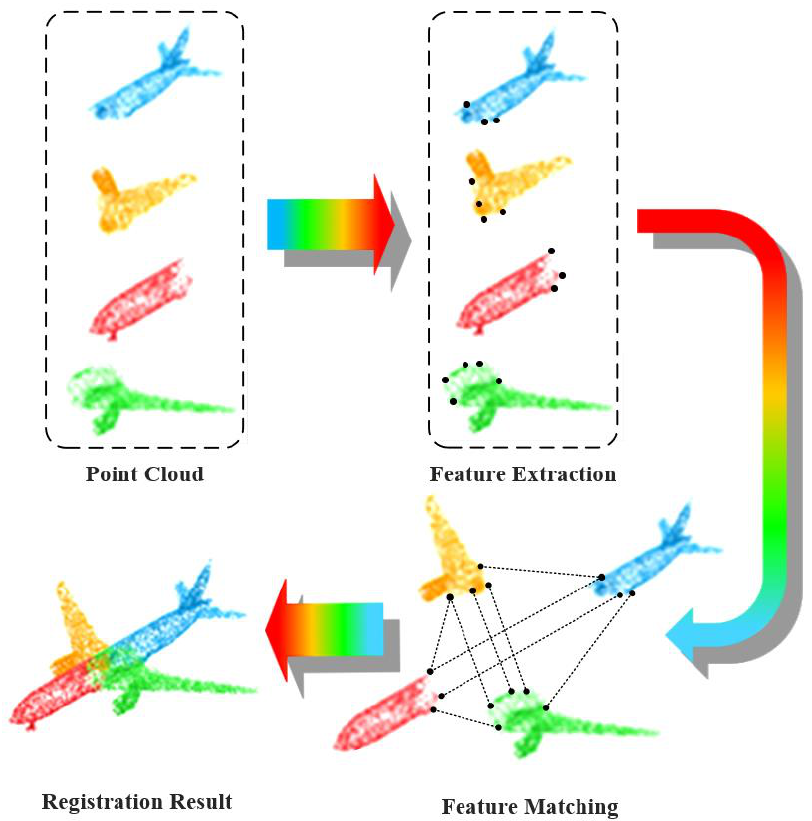
Figure 8. Typical feature-based point cloud registration algorithm process.